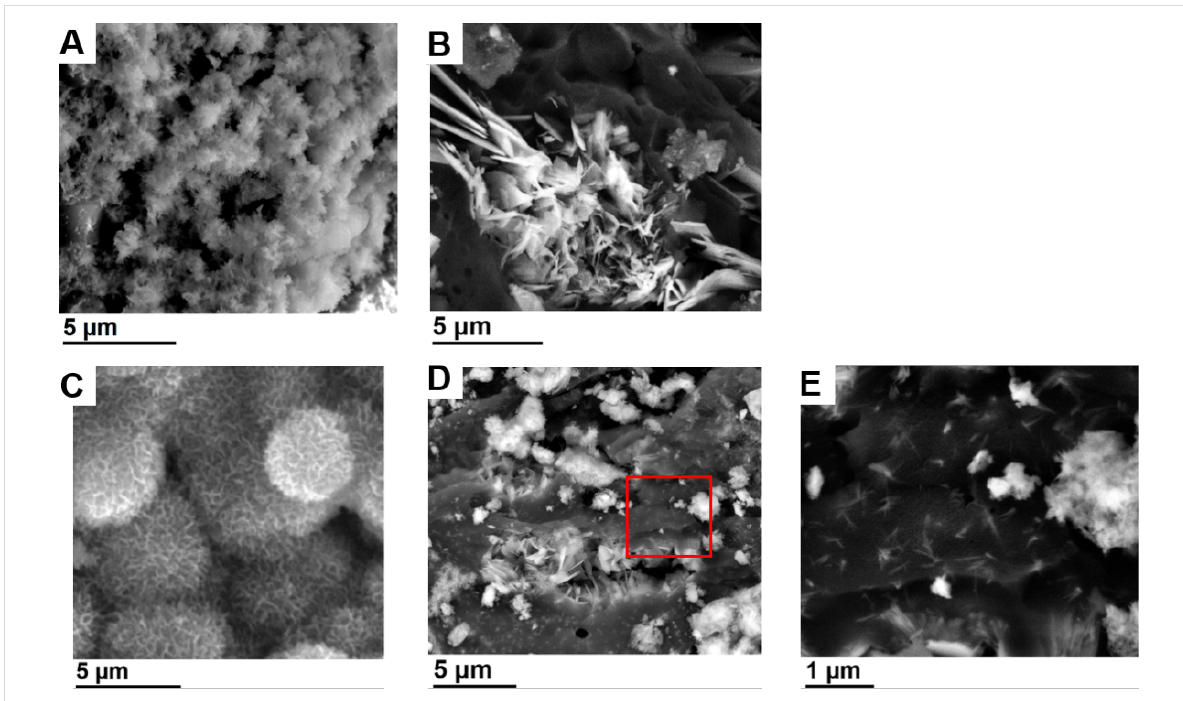
Figure 6: SEM images of the hydrogels after mineralization: (A) IK24 and (B) H3AH3 hydrogels after 4 days of mineralization. (C) IK24 hydrogel after 14 days of mineralization. (D) H3AH3 hydrogels after 14 days of mineralization. (E) High magnification SEM micrograph of the red framed region in D.